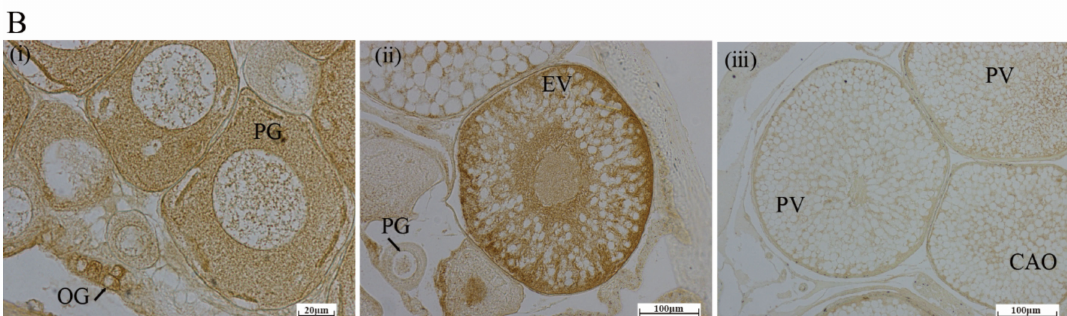
Figure 4. Expression of bmpr2 in developing ovaries was analyzed in ricefield eel, Monopterus albus . ( A ), Expression of bmpr2 during ovarian development. ( B ), The localization of Bmpr2 immunoreactive signals (yellow and dot-like) in the ovary. ( i ), Primary growth stage; ( ii ), early vitellogenic stage; ( iii ), negative control. EV, early vitellogenic stage; MLV, middle to late vitellogenic stage; OM, oocyte in mature stage; OG, oogonium; PG, primary growth stage; PV, previtellogenic stage. Results are expressed as means ± SEMs ( n = 5). * and **** are the significant differences in Duncan’s multiple comparisons, representing * p < 0.05 and **** p < 0.0001, respectively.